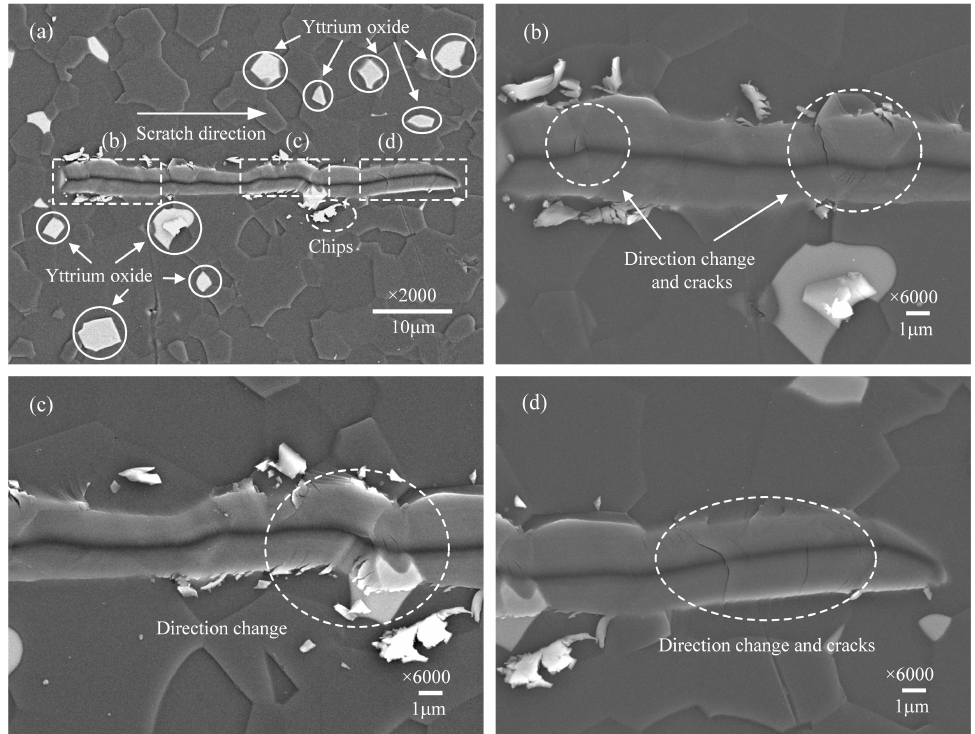
Figure 4. Surface morphology of the scratch groove at the scratch speed of 1 μ m/s. ( a ) is the overall morphology. ( b – d ) are detailed enlarged views.